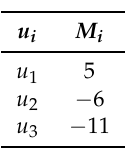
Table 2. Score of ( u i )